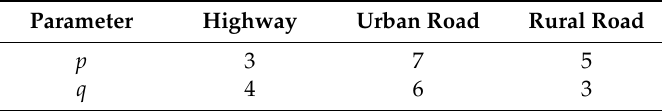
Table 1. Recommended values of ground clutter parameters.